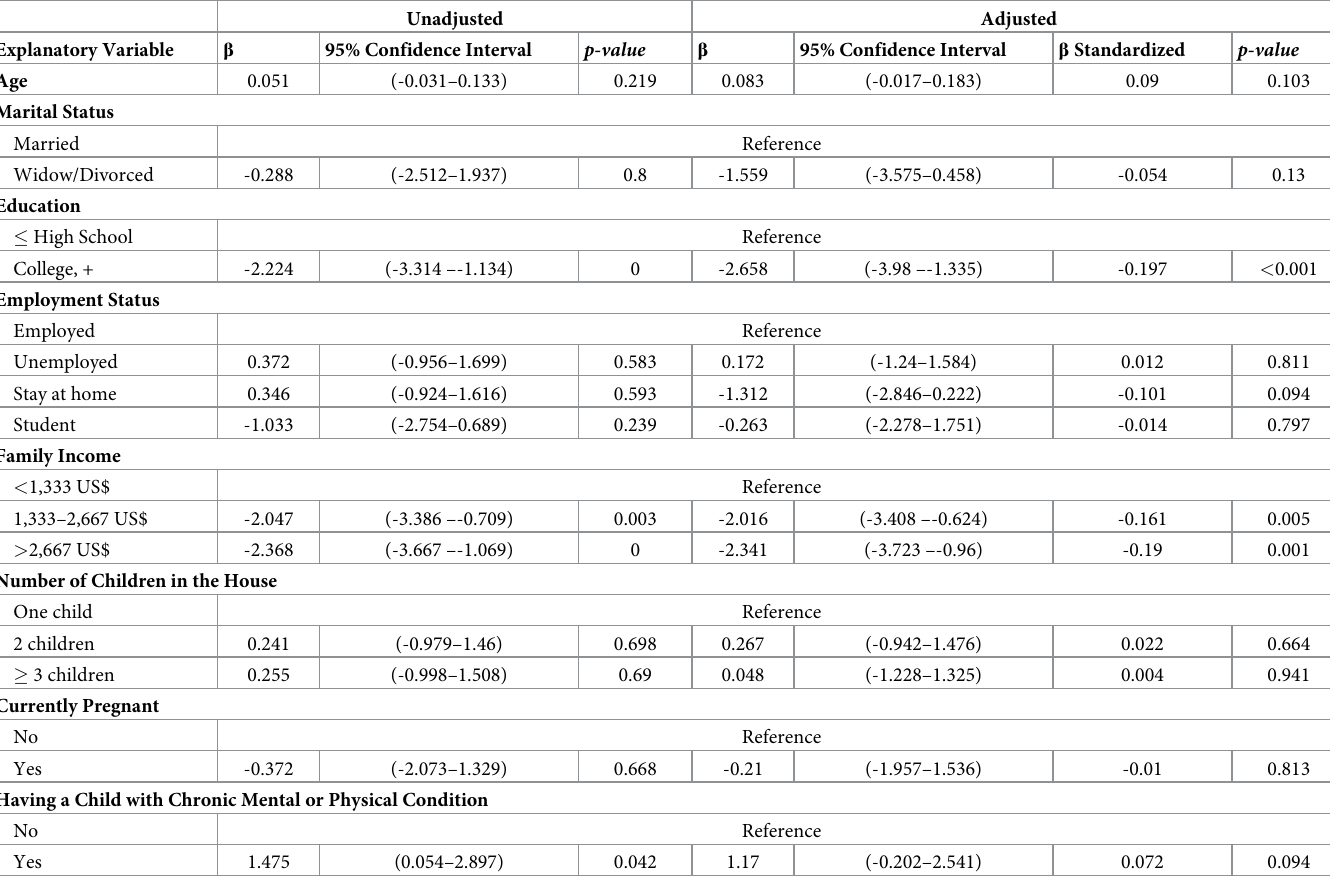
Table 3. Parameter estimates of the explanatory variables from ordinary least squares regression outcome relative to mothers’ fear of their children contracting COVID-19 ( n =